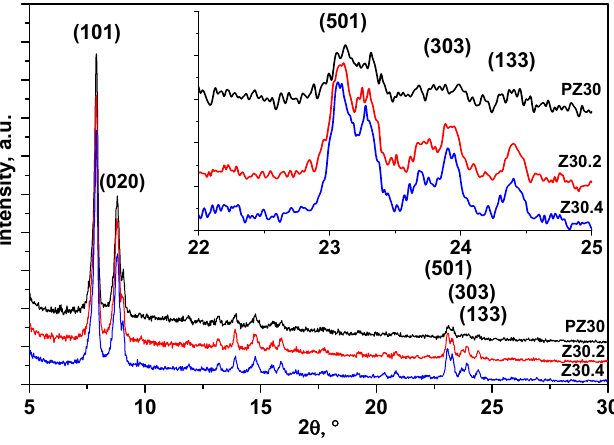
Figure 1. XRD patterns of PZ30 (top, black), Z30.2 (middle, red), and Z30.2 (bottom, blue).